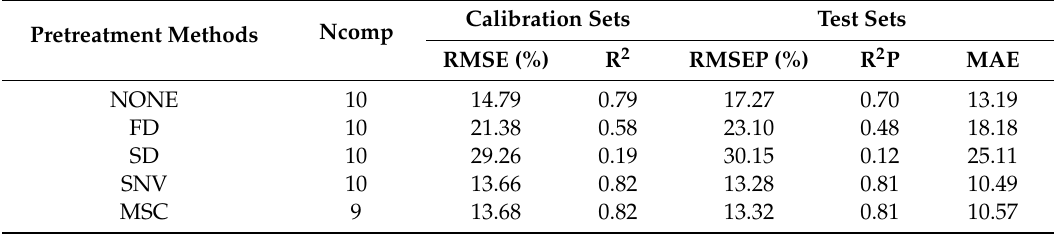
Table 2. The partial least squares regression (PLSR) modeling results for four preprocessing methods.